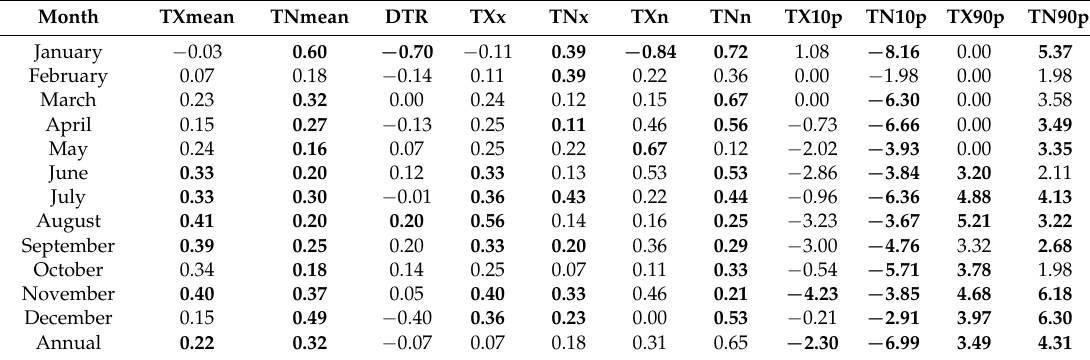
Table 5. Temperature extreme trends at station 41638 from 1985 to 2015. Bold color indicates significant trend at a 95% significance